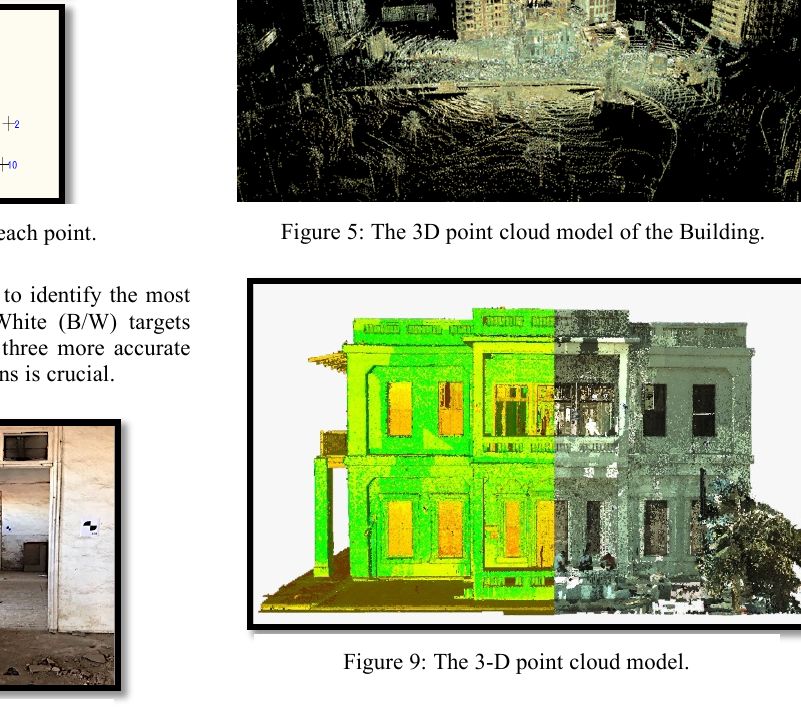
Figure 8: Black and White (B/W) targets.